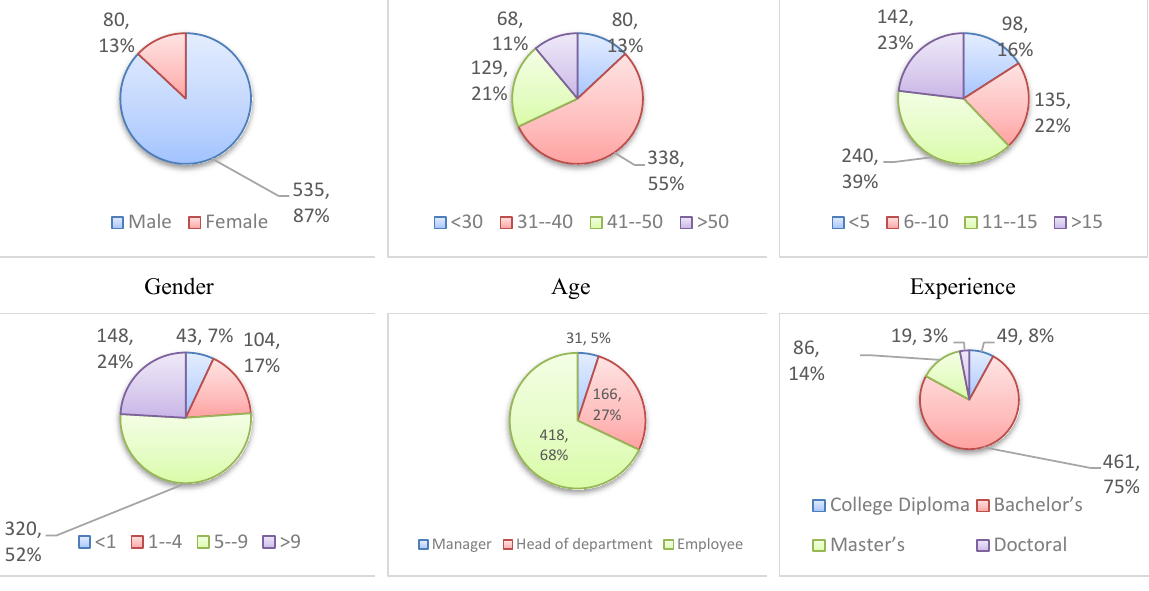
Fig. 2. Descriptive and Inferential